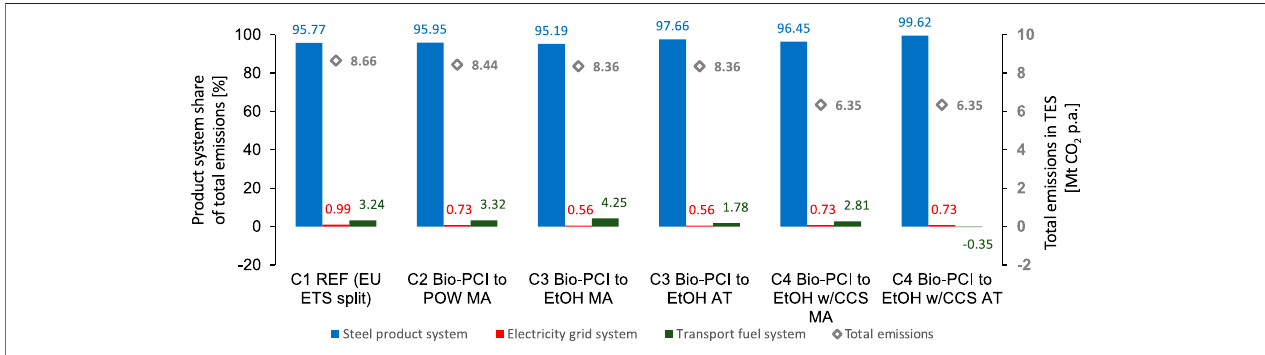
FIGURE 8 | Total emissions in TES and their distribution into the three product systems for the studied steel mill con fi gurations C1 – C4 depending on allocation by mass(MA)orattribution(AT).Thegridintensityis295.6gCO